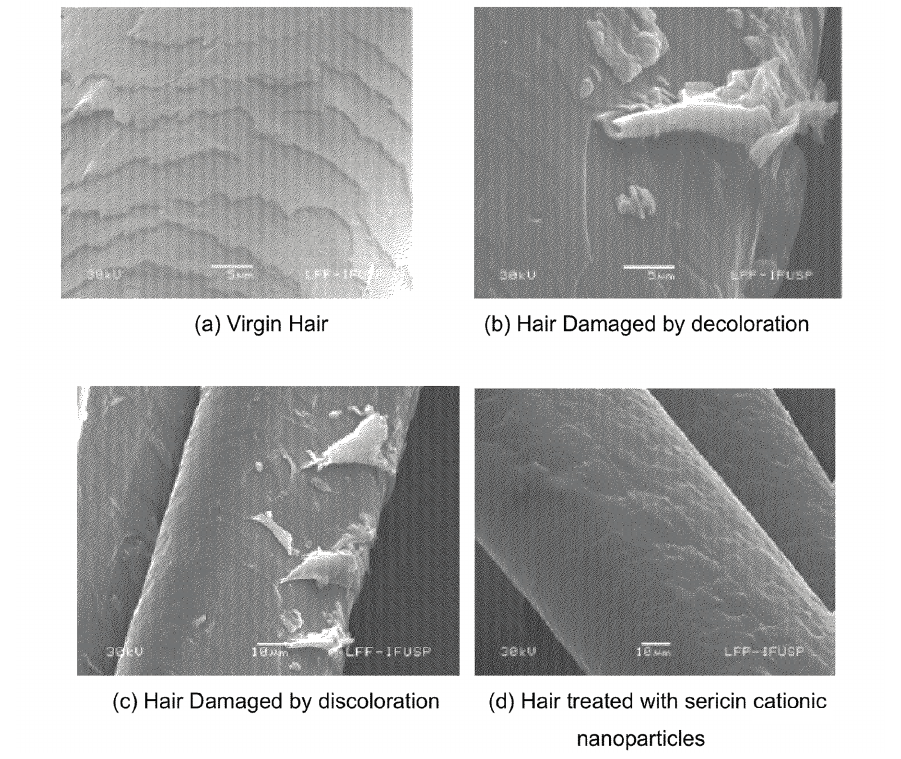
Figure 3. Images of virgin hair ( a ), hair damaged by coloring agents ( b , c ) and hair treated with seracin cationic nanoparticles ( d )